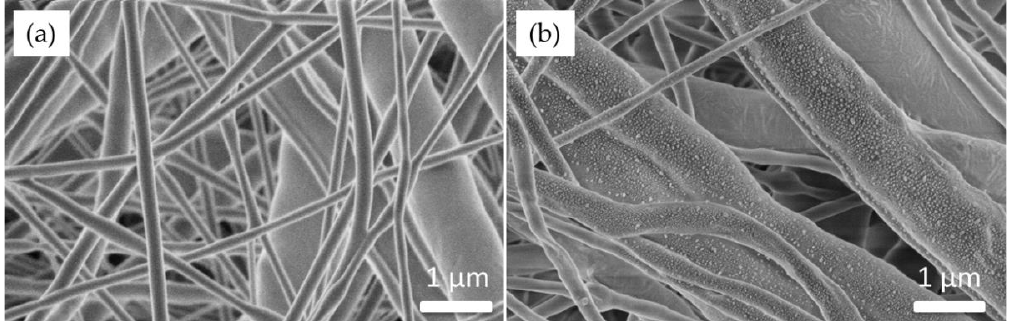
Figure 3. Close-up SEM micrographs at low voltage showing ( a ) the fibers in the bare sample vs. ( b ) fibers of the Ag-coated one, where silver decoration is clearly visible.